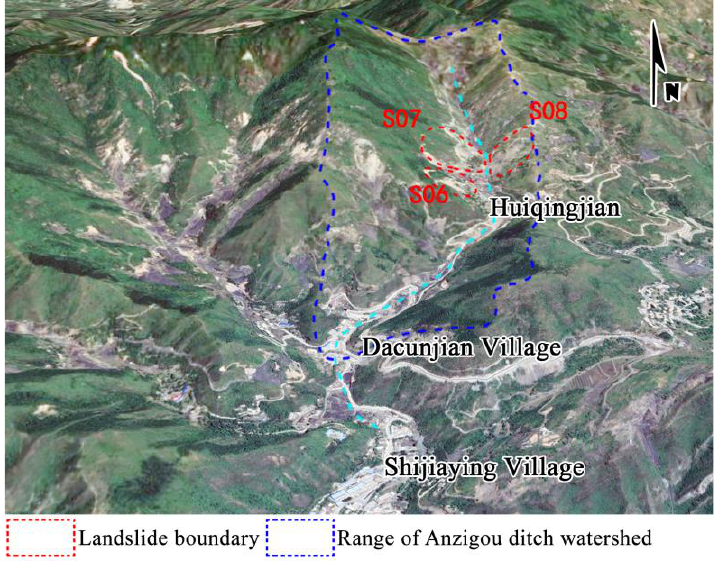
Figure 18. 3D map of Anzi Ditch.